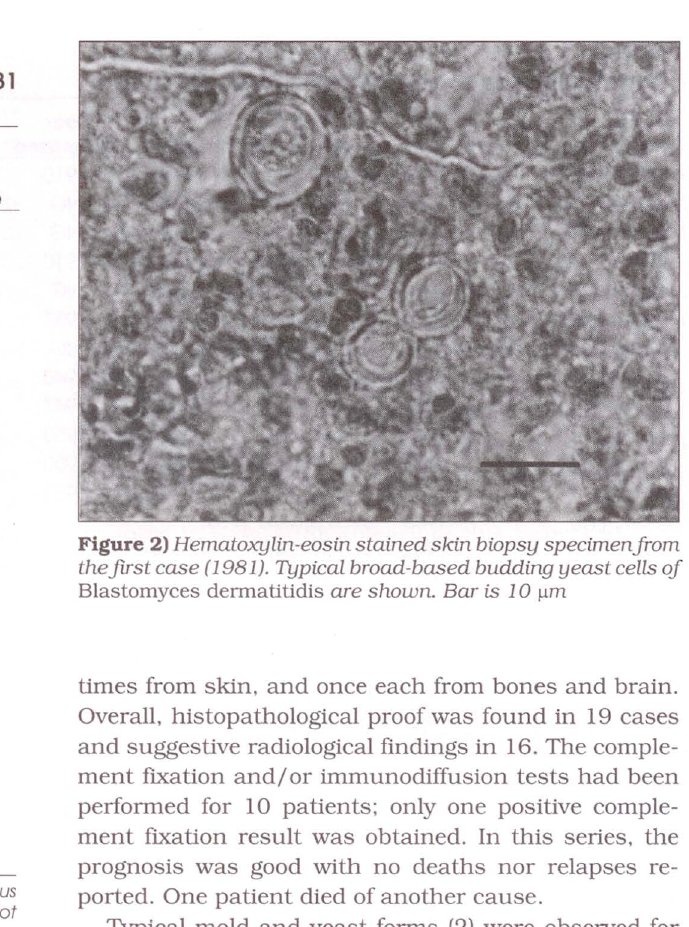
Figure 2) Hematoxylin-eosin stained skin biopsy specimen .from thefrrst case (1981}. Typical broad-based budding yeast cells